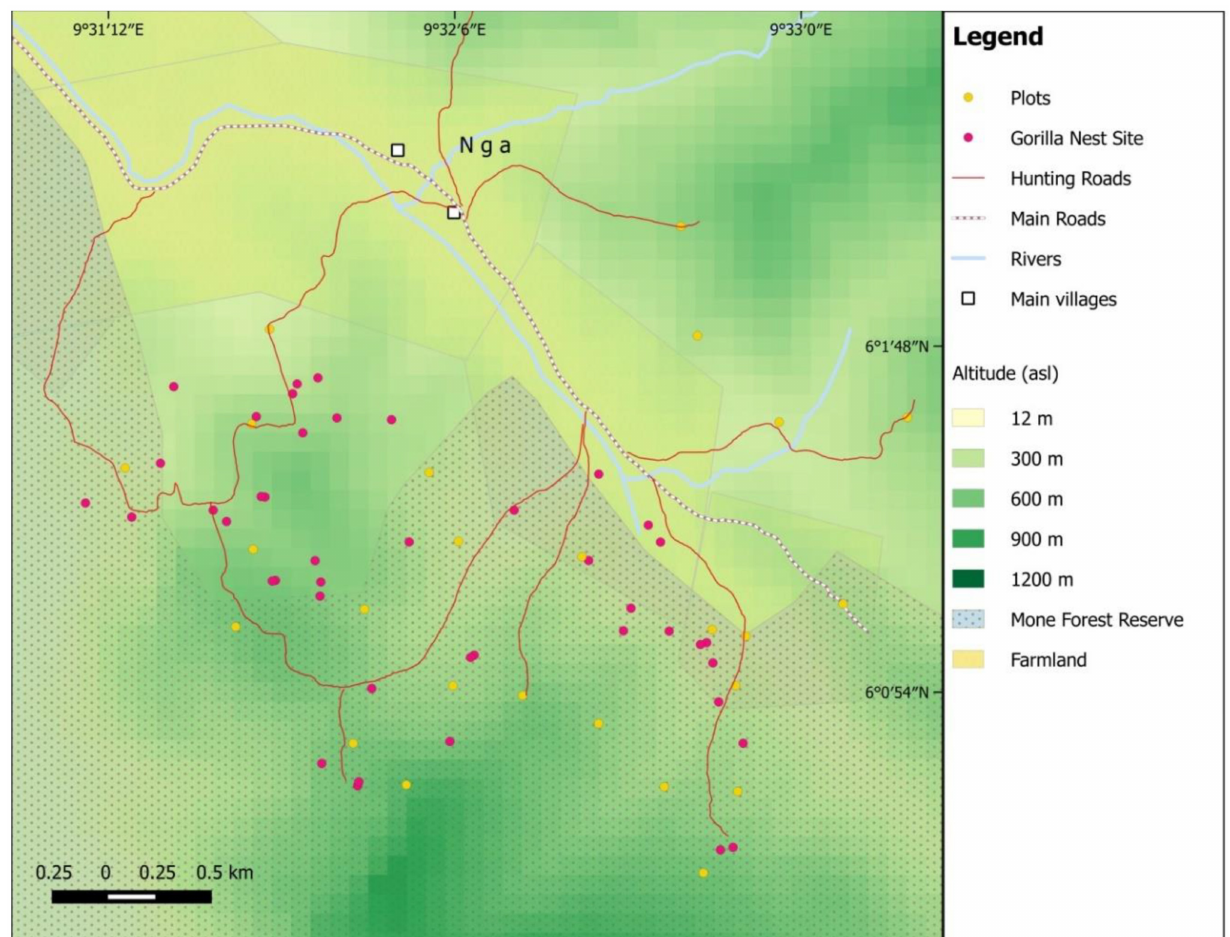
Figure 2. A map of gorilla nest sites and botanical plot locations within the gorilla nesting zone of the Mone-Oku Forest.